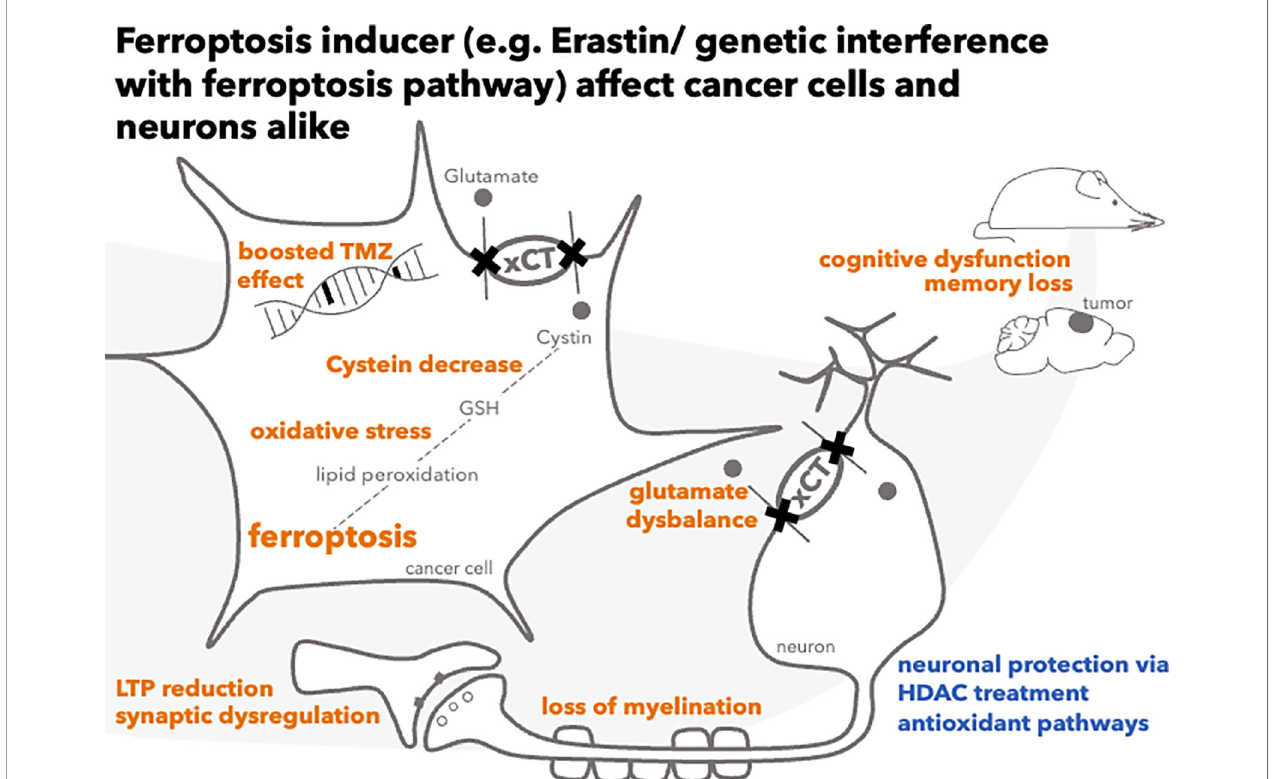
FIGURE 1 | Consequences of ferroptosis induction in cancer cells and